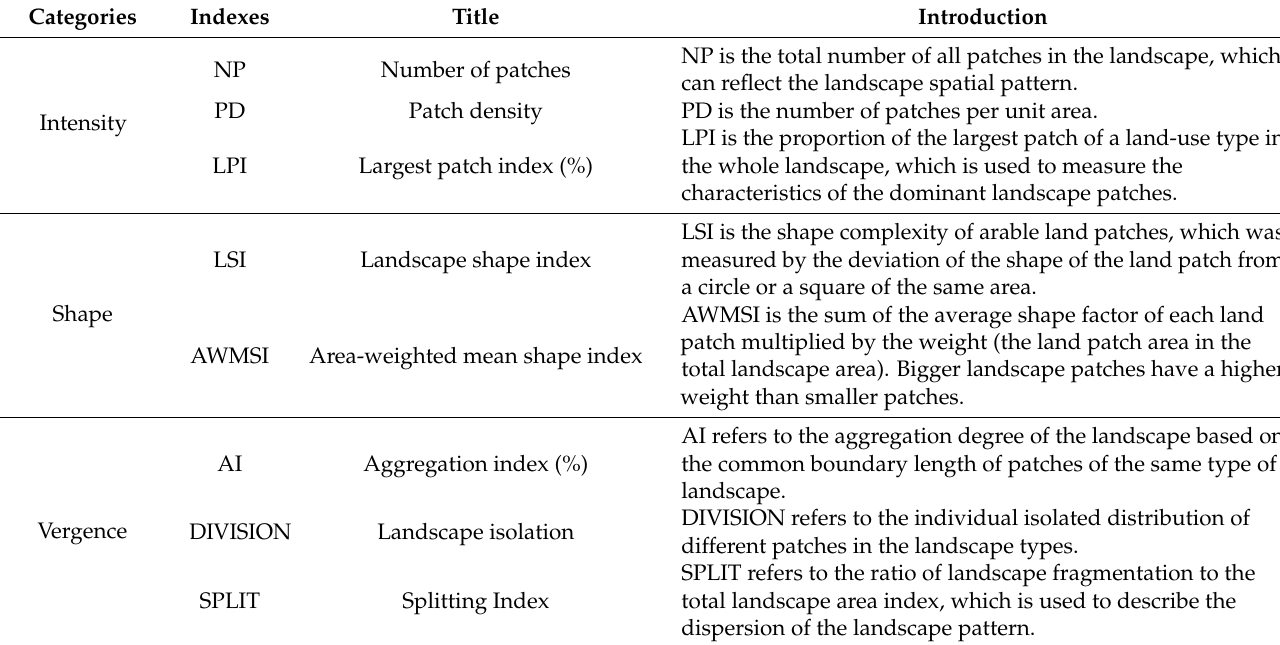
Table 2. Introduction of the landscape